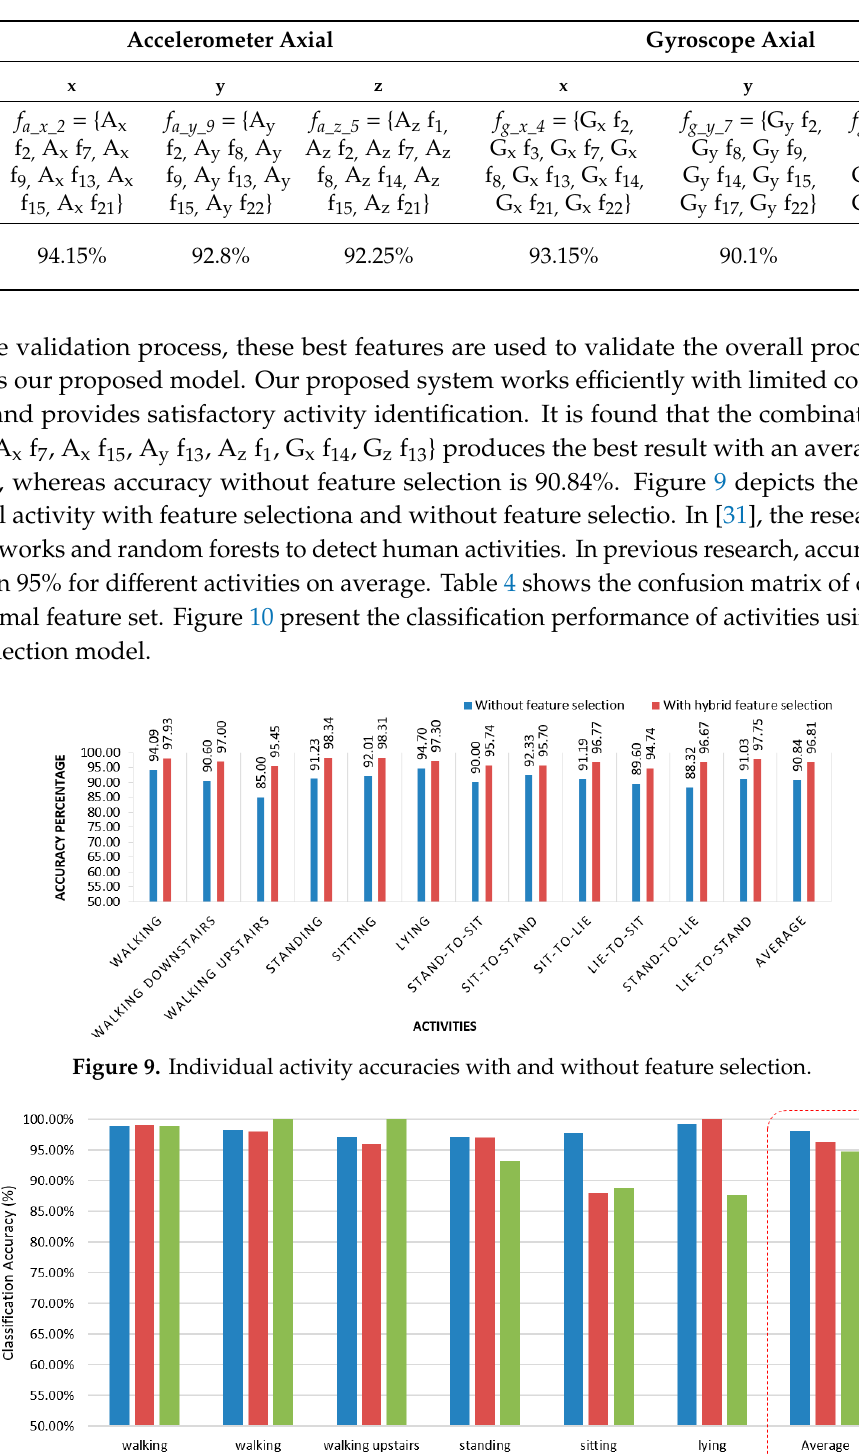
Figure 10. Comparison of accuracy of different classification model.